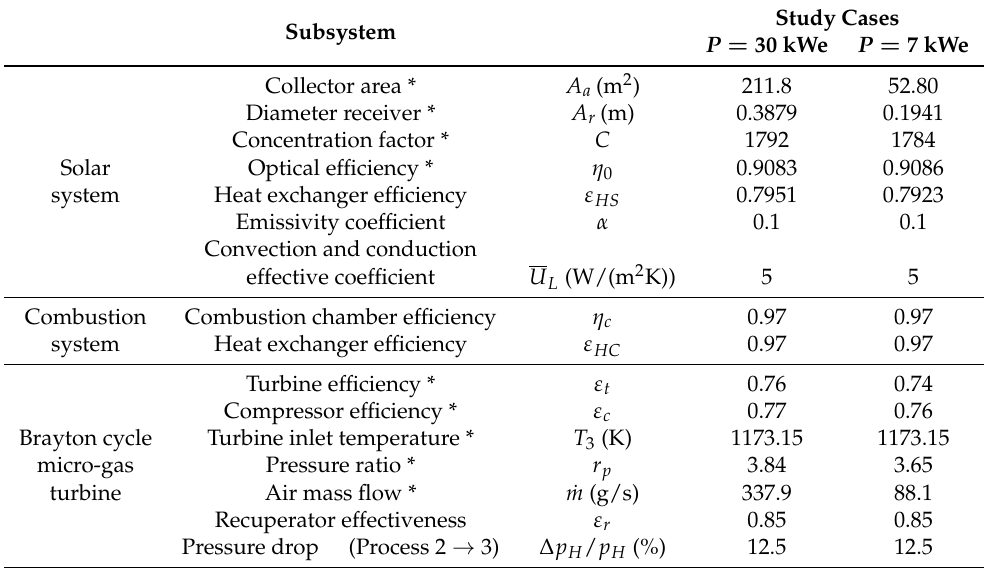
Table 1. Parameters extracted from Semprini et al. [31] (*) and those taken to validate our model. The validation target is the micro-gas turbine Capstone C30